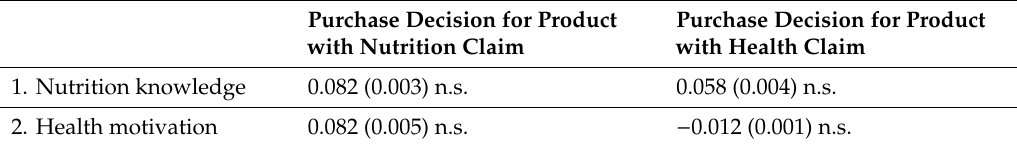
Table 8. Total e ff ects and their e ff ect sizes—nutrition and health